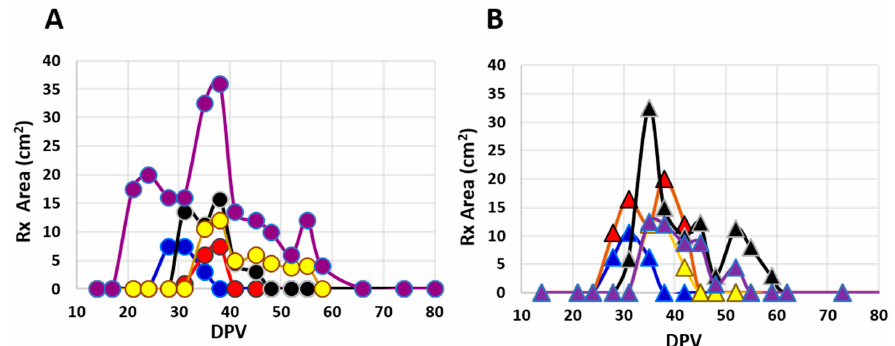
Figure 2. Areas (L × W) of palpable injection site reactions over time (days post-vaccination; DPV) in individual cattle from Safety Study #2 following inoculation with one of two EBAA vaccine serials. Potencies of serials were ( A ) 8700 or ( B ) 6000 P.a. -LIC with group sizes of five animals each.